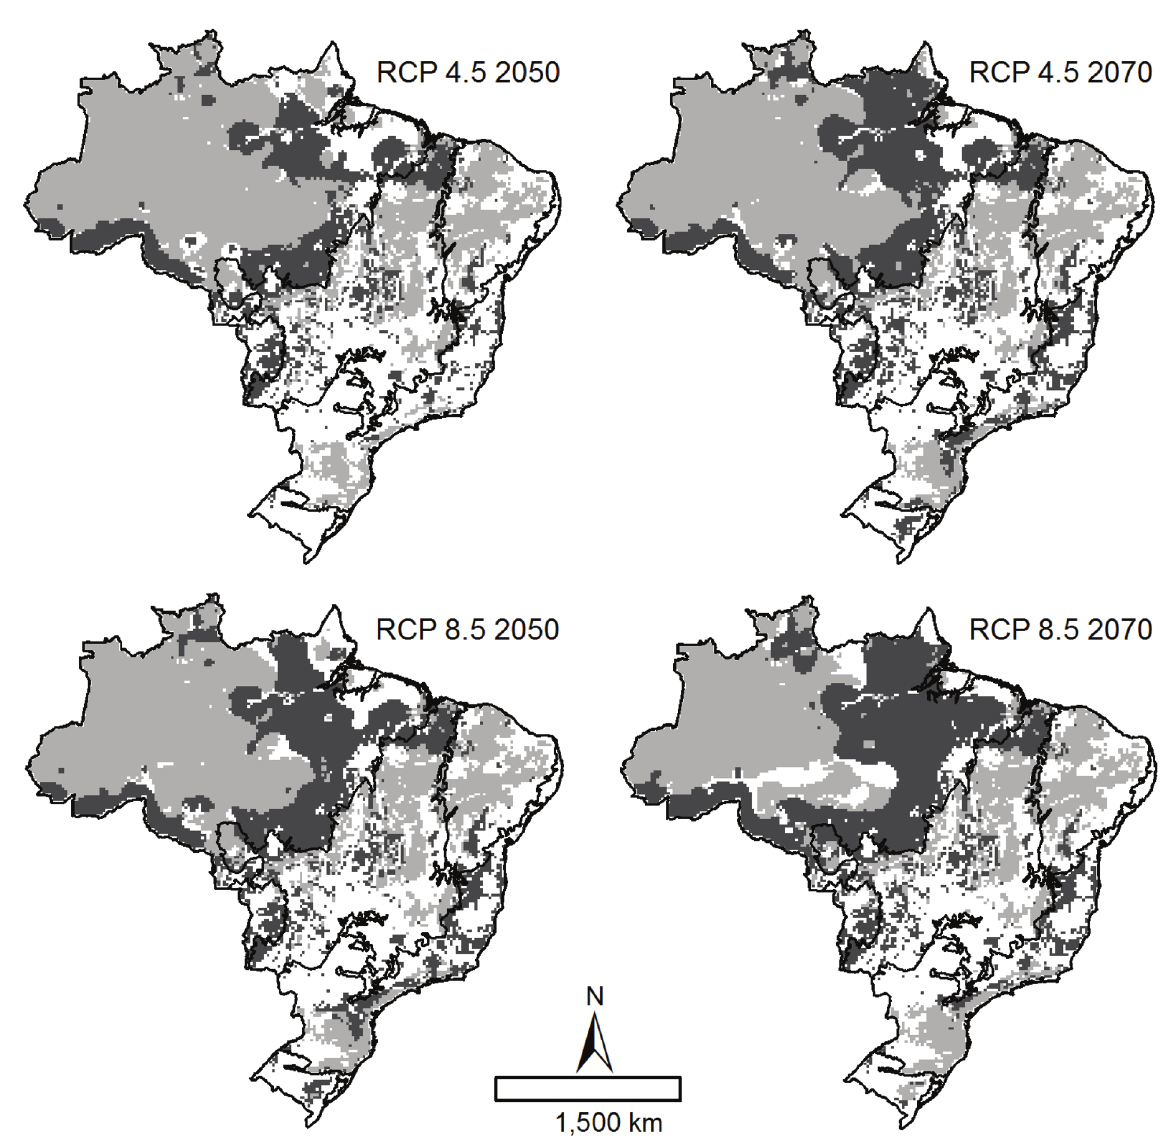
Figure 5 - Future landcover categories and vulnerability sites. Vulnerability sites are those where current landcover is not predicted to occur in future climate scenarios (dark gray). Locations of climatic stability (where current landcover is predicted to occur in future climate scenarios) are represented by light gray. White areas are those under anthropogenic use and were not evaluated